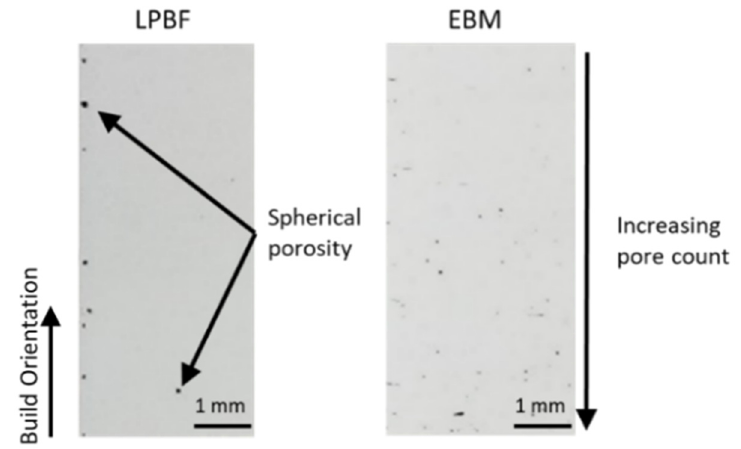
Figure 4. Cross-sections of LPBF and EBM samples.